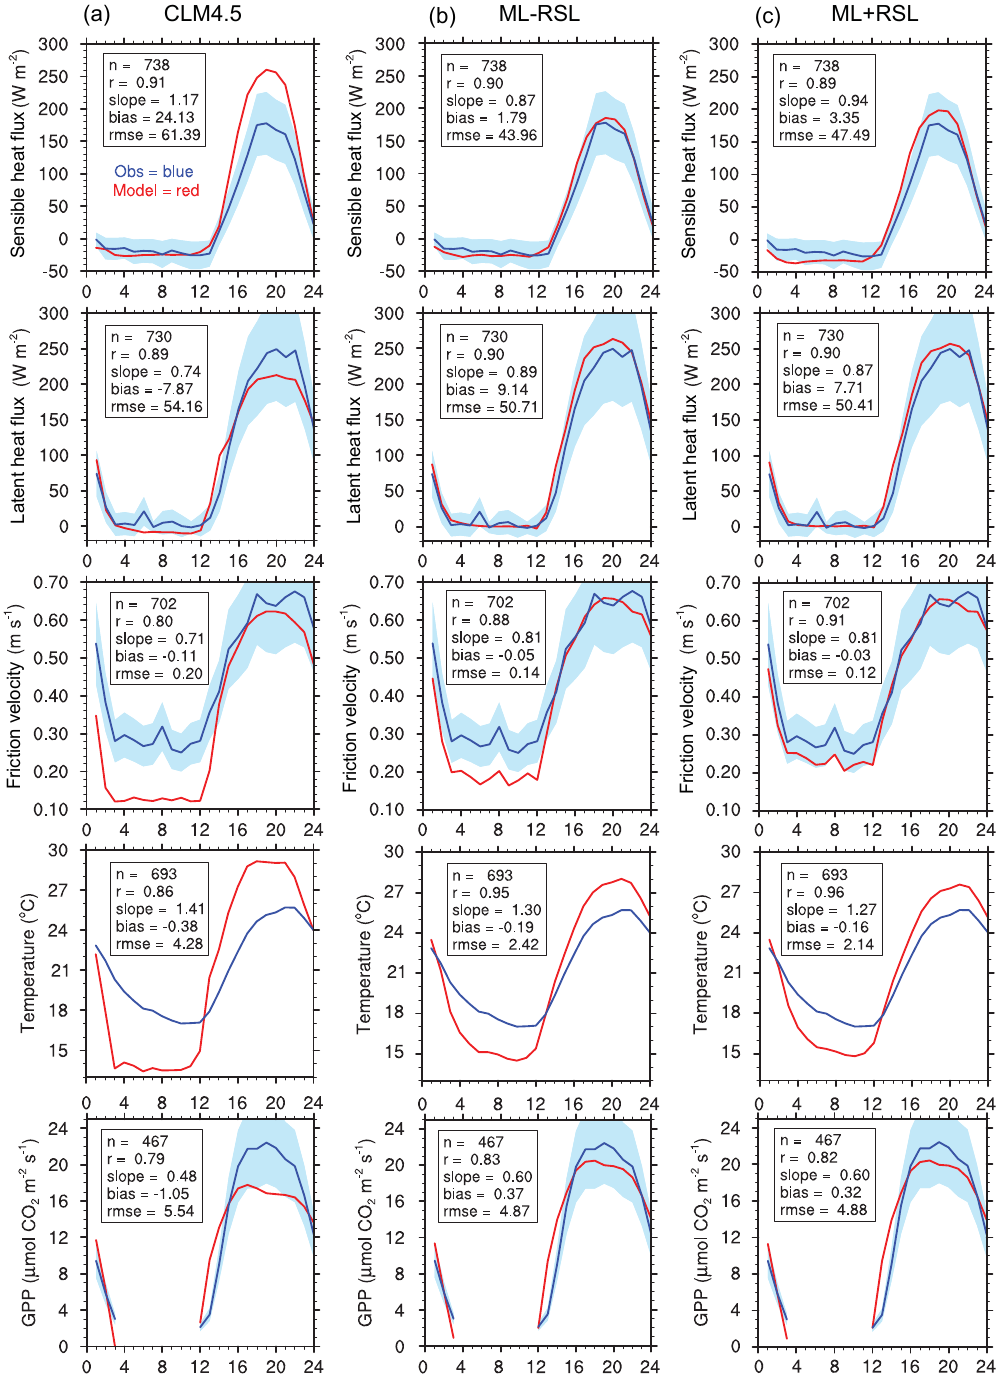
Figure 4. Simulations for US-UMB (July 2006). Shown are the average diurnal cycle (GMT) of sensible heat flux, latent heat flux, friction velocity, radiative temperature, and gross primary production (GPP) for the observations (blue) and models (red). The shading denotes ± 1 standard deviation of the random flux error (Richardson et al., 2006, 2012) for H and λE and ± 20% of the mean for GPP and u ∗ . Statistics show sample size ( n) , correlation coefficient ( r) , slope of the regression line, mean bias, and root mean square error (rmse) between the model and observations. (a) CLM4.5; (b) ML-RSL; (c) ML +